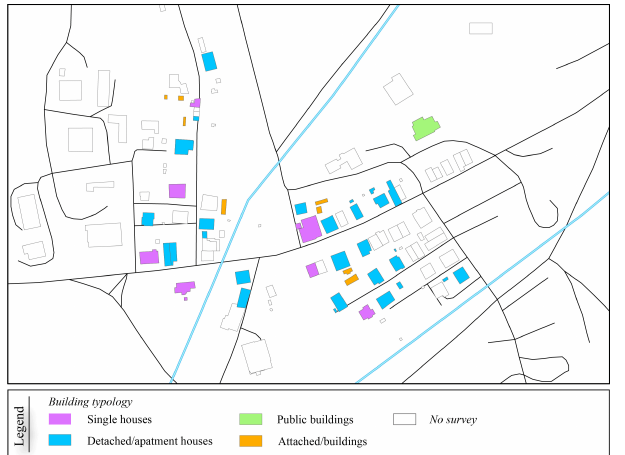
Fig. 4. Surveyed buildings in Città della Pieve by building type. Fig. 5. Contaminants in the surveyed buildings in Città della